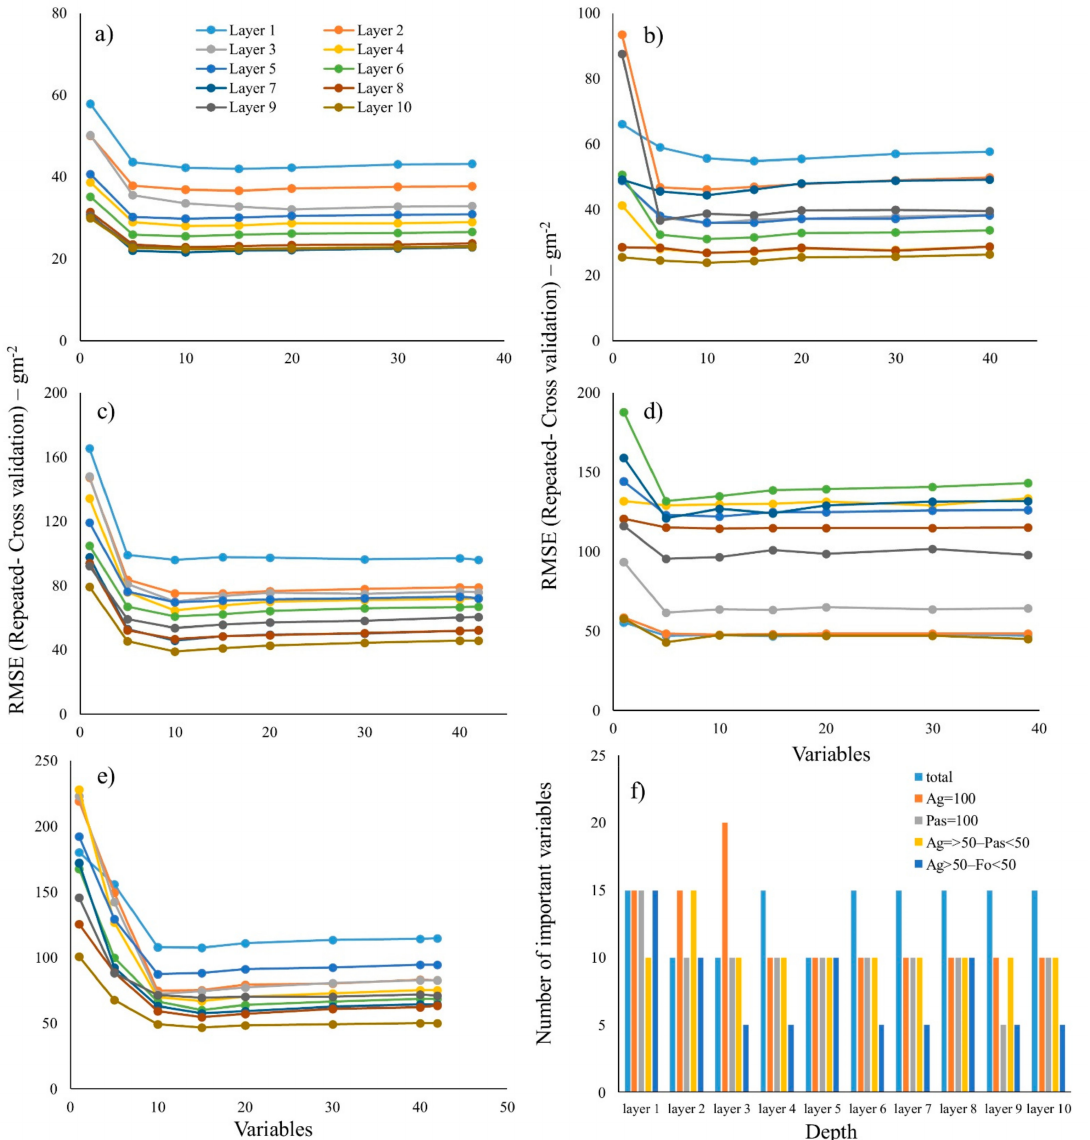
Figure 5. RMSE values in five-fold cross-validation in the process of selecting the number of important variables in each LULC history class and depth with RFE algorithm ( a ) Ag = 100, ( b ) Pas = 100, ( c ) Ag > 50–Pas < 50, ( d ) Ag > 50–Fo < 50, ( e ) total samples, ( f ) the number of important variables selected with RFE for each depth and each LULC history